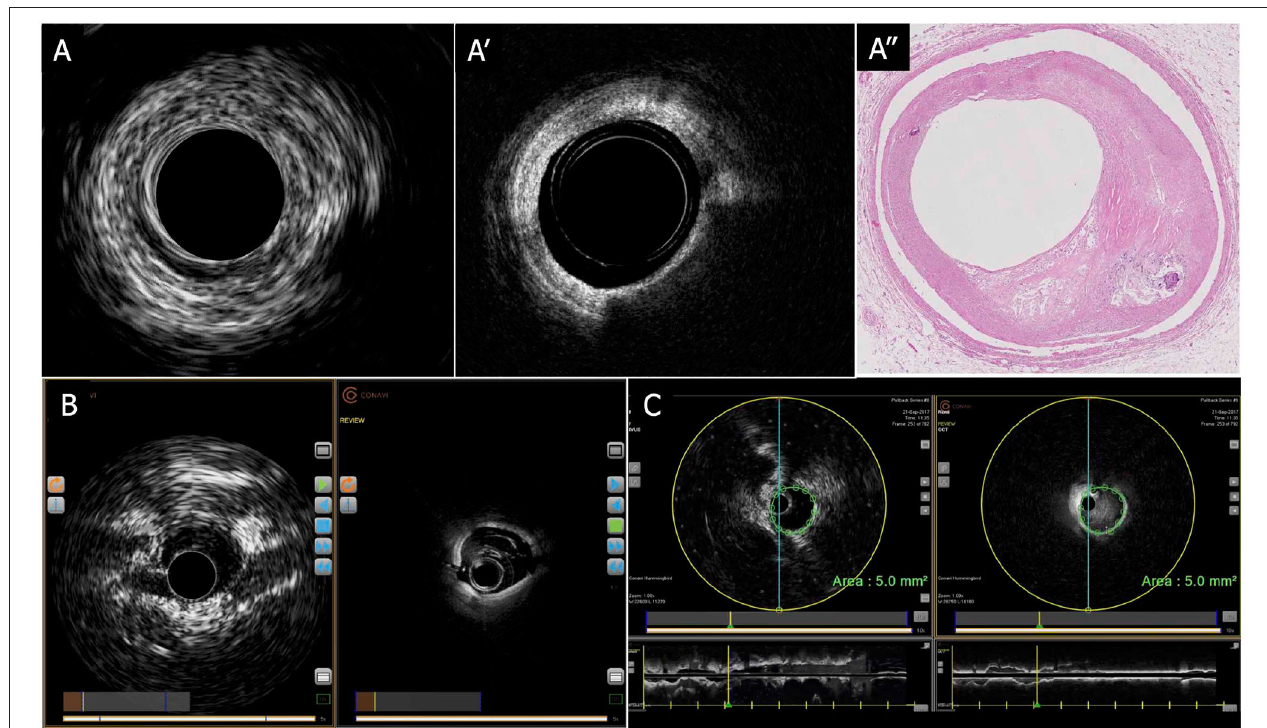
FIGURE 5 | CONAVI Novasight hybrid imaging catheter; sample images. (A) Coregistered intracoronary images of superficial atheroma in IVUS (A-1) and OCT (A-2), and corresponding histopathology (A-3). (B) Preclinical in vivo images. (C) Measurements of lumen size by the coregistered image of IVUS and OCT. By default, any measurements (areas, distances) made in an IVUS image are automatically copied over into the OCT image and vice versa. The copied measurement can be removed. IVUS, intravascular ultrasound; OCT, optical coherence tomography.